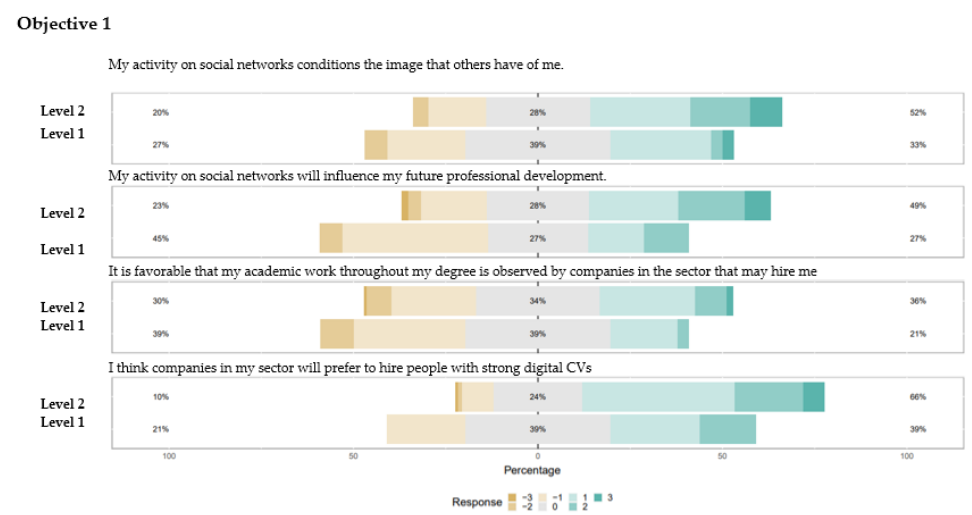
Figure 5. Differences according to levels of participation between pre-test and post-test for objectives 1 ( top ) and 2 ( bottom ). Own elaboration.